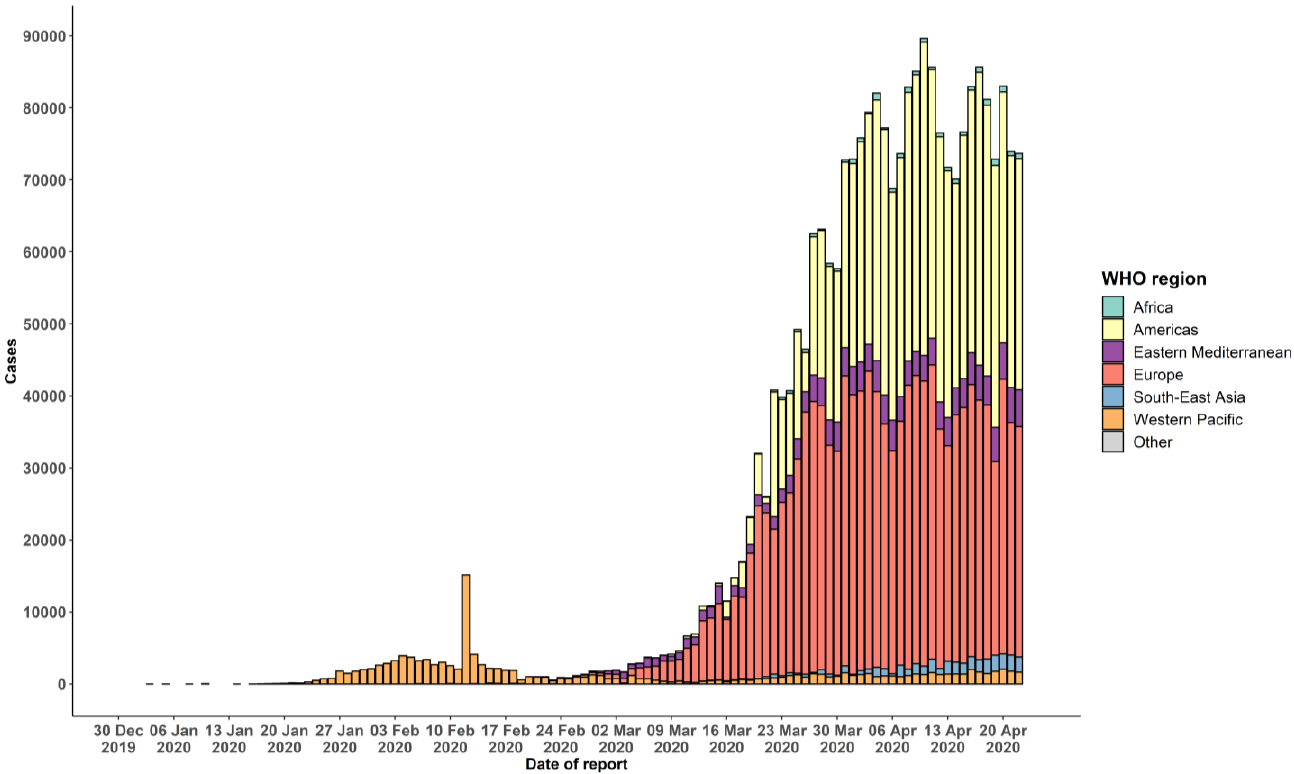
Figure 4. Epidemic curve of confirmed COVID-19, by date of report and WHO region through 23 April